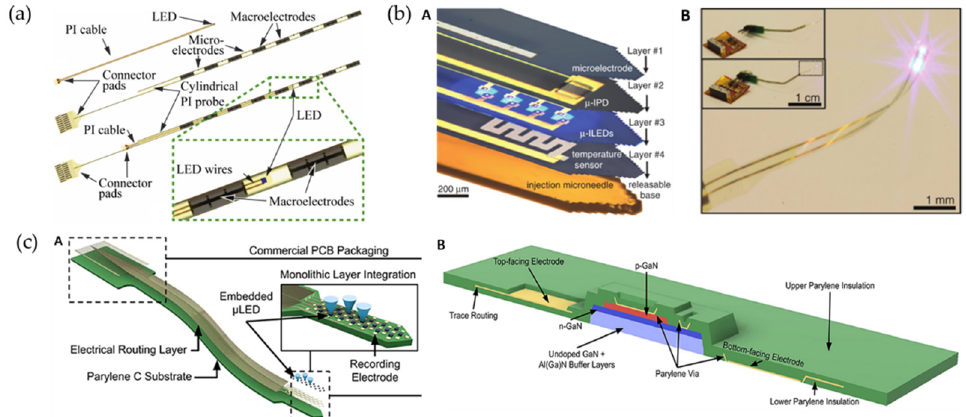
Figure 4. Several ways to implement flexible optoprobes: ( a ) Schematics of the cylindrical flexible optoprobe, in which a PI-based ribbon cable interconnects a bare LED chip by flip-chip bonding to respective connector pads. Close-up view showing the placement of the LED chip in a cylindrical transparent optoprobe between two macroelectrodes [132]. ( b ) Optoprobes design for transfer of printed μ -LED from sapphire wafer to a flexible polyester substrate: A: Schematic diagram of its multi-layer structure; B: Integrated system wirelessly powered with RF scavenging [134]. ( c ) Schematic illustration of the probe architecture with integrated GaN μ -LEDs and recording electrodes on a flexible substrate using a standard microfabrication process. A: Schematic illustration of the probe architecture with a flexible Parylene C cable; B: Schematic cross-section of active region [127]. Reprinted under a Creative Commons Attribution (CC BY) license.